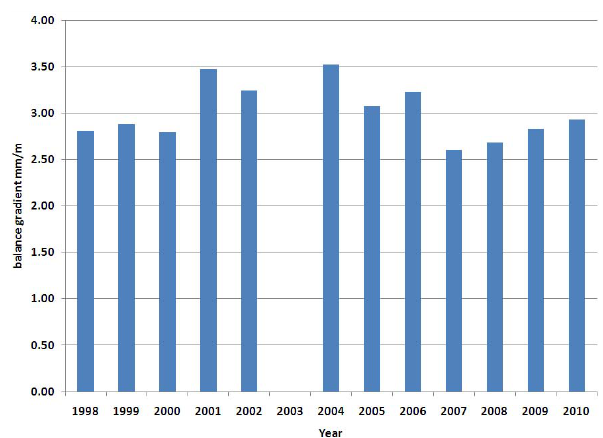
Fig. 5. Balance gradient on Taku Glacier between the snowpits and the transient snowline, based on snowpit data 1998–2010, except 2003 when the TSL was nearly at the snowpits.